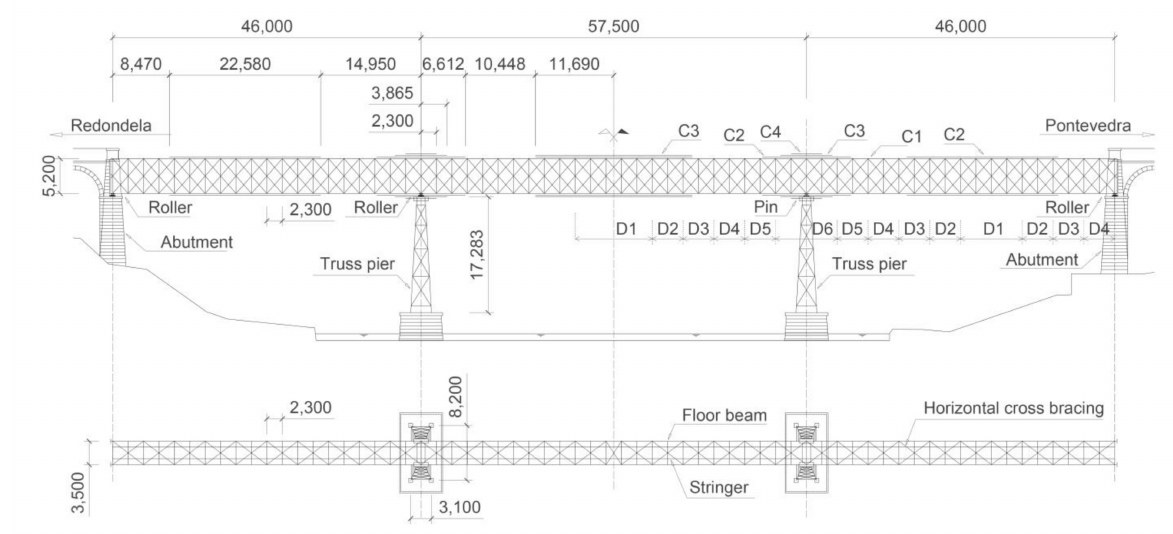
Figure 1. Redondela Bridge drawings: elevation and plan views (all dimensions in